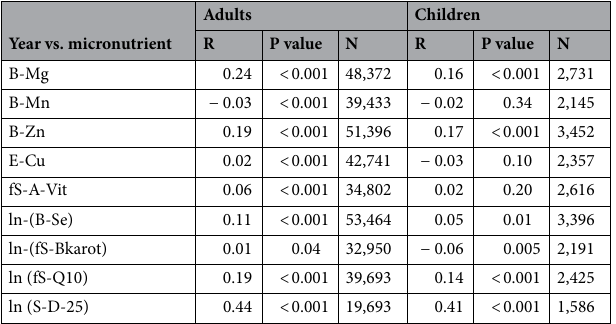
Table 1. Pearson’s correlation coefficients (R) between the calendar year and micronutrients in adults and